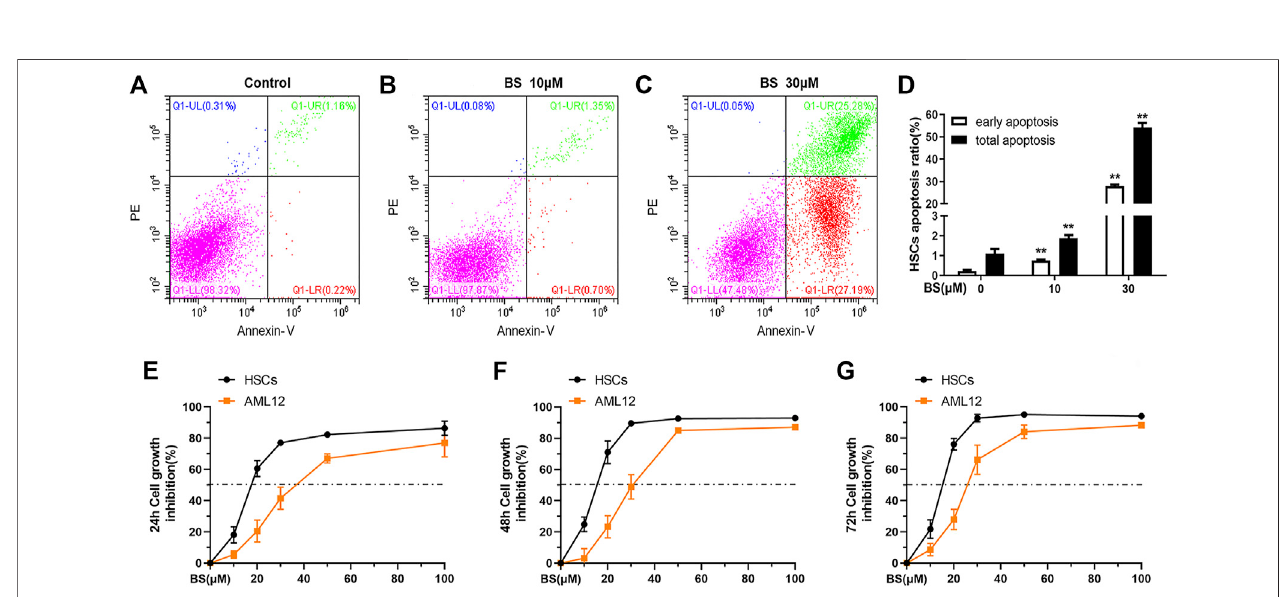
FIGURE 3 | BS induced apoptosis of activated HSCs. (A – D) Annexin V-PI analysis and statistical analysis of early apoptosis and total apoptosis rates were presented after BS treatment for 24 h on HSCs. Cell inhibition curves were assessed by the SRB assay under different incubation time of BS on HSCs and AML12 (E: 24 h, F: 48 h, G: 72 h). HSCs were induced by 5 ng/ml TGF- β 1. Data were shown as mean ± SD, n ≥ 3 and analyzed with the one-way ANOVA. ** p < 0.01, 10 – 30 μ M BS groups versus the 0 μ M BS